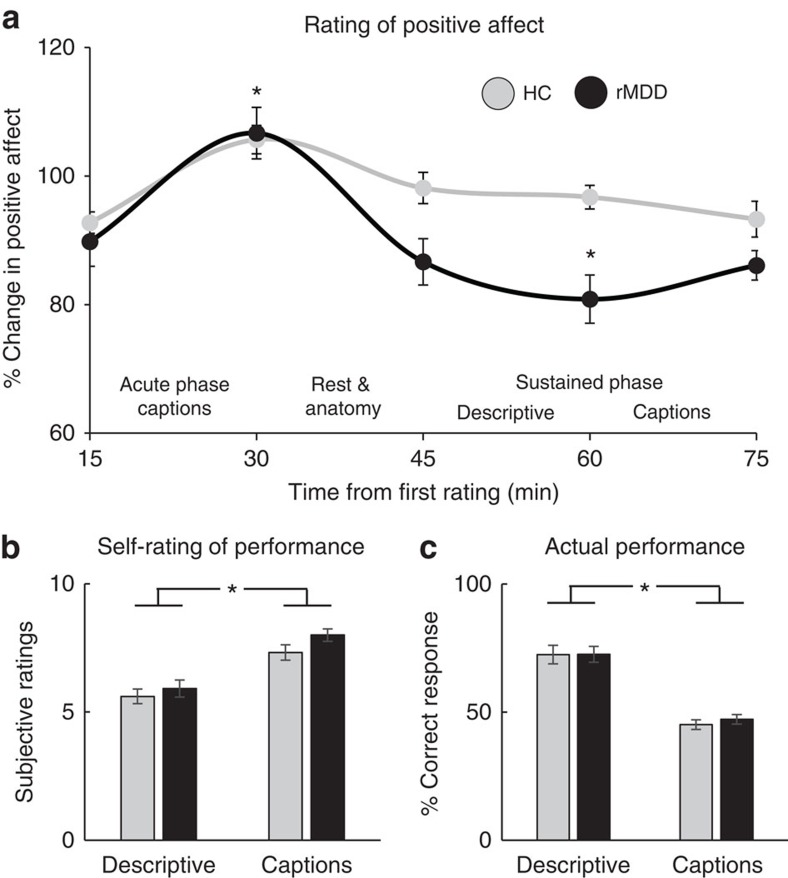
Affective responses to the positive mood induction.(a) Mixed ANOVA revealed that both groups exhibited a significant increase in positive mood immediately following the mood induction manipulation (that is, following Acute Phase Captions), yet only controls had a sustained elevation in positive affect over time. Specifically, for controls, but not rMDD, positive mood did not decline for at least 30 min following the mood induction. Mixed ANOVA for self-rating of performance in the task (b) and actual performance (c) revealed significant differences between the descriptive and captions tasks, although in opposite directions. Participants, across groups, rated their performance to be better in the captions compared with descriptive task, yet their accuracy was actually better in the descriptive compared with the caption task. Taken together, affective responses suggest that participants were engaged in the task and perceived the positive feedback during the captions task as reliably reflecting their performance, which in turn led to a successful induction of positive mood across groups in an ecologically valid and naturalistic way. Bars ±1 s.e.m. *P<0.05. HC, healthy controls (n=25); rMDD, remitted individuals with a history of recurrent MDD (n=25).